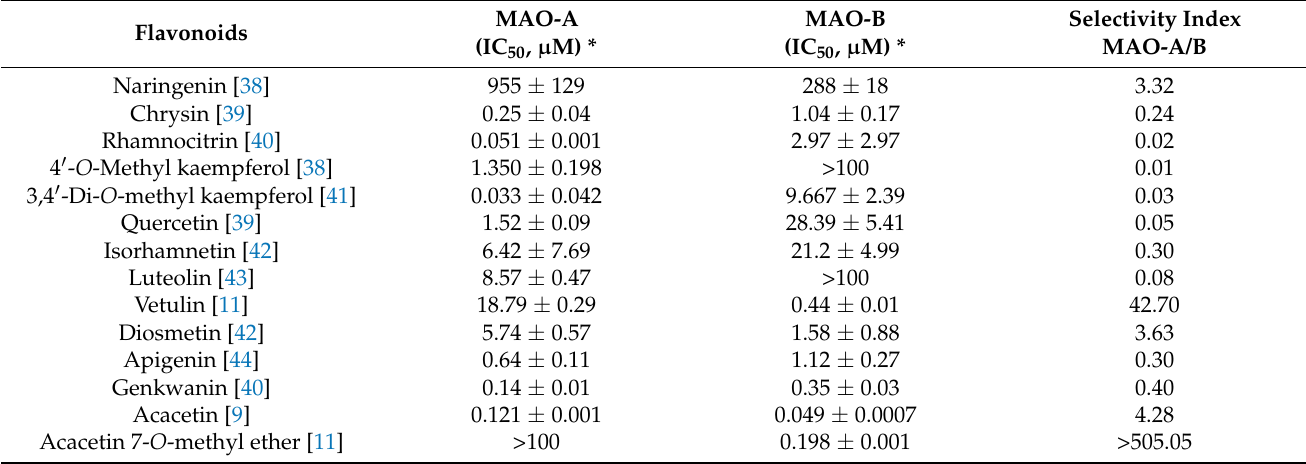
Table 1. Comparison of the IC 50 values of acacetin and acacetin 7-O-methyl ether with known